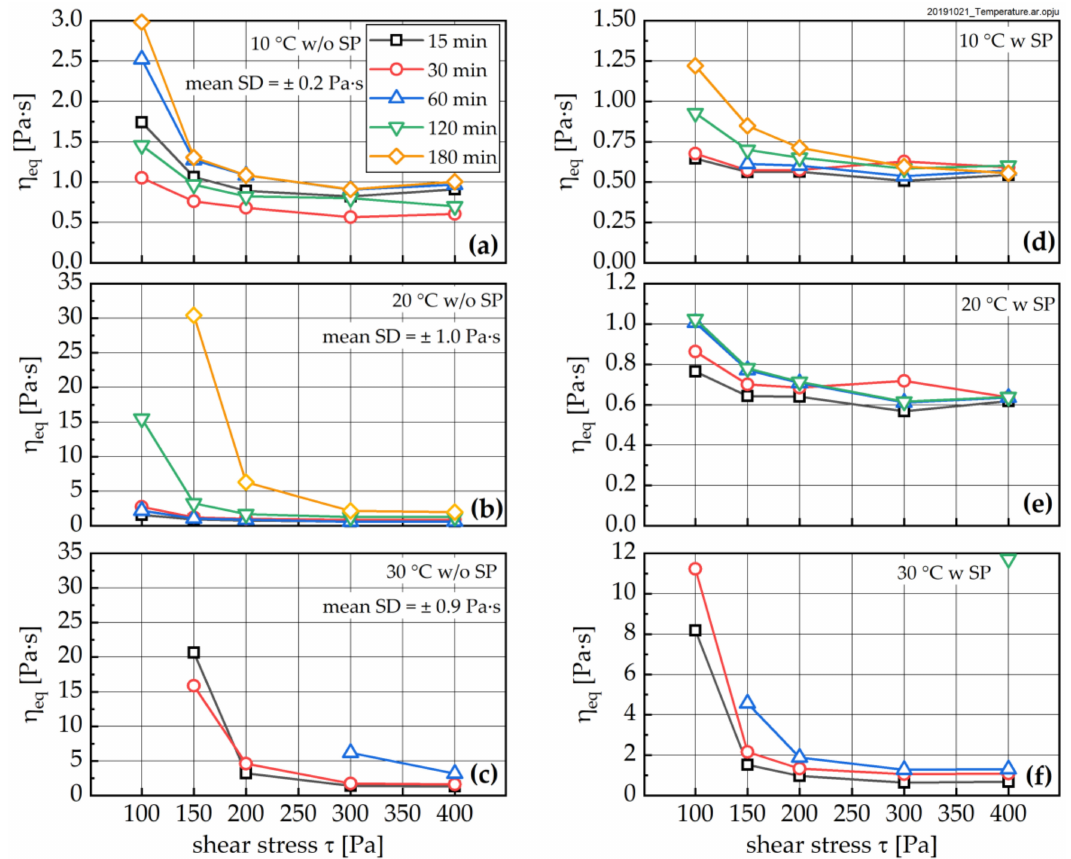
Figure 9. Change of equilibrium viscosity ( η eq ) as a function of applied shear stress for samples without (left; a – c ) and with superplasticizer (right; d – f ) for temperatures of 10 ◦ C ( a , d ), 20 ◦ C ( b , e ) and 30 ◦ C ( c , f ). Note, the 30 ◦ C samples and higher ages values were not measurable, as the samples became too sti ff for rheometer measurements. Mean standard deviation (SD) was calculated from three repetitions each time, and all shear stresses at corresponding temperature without